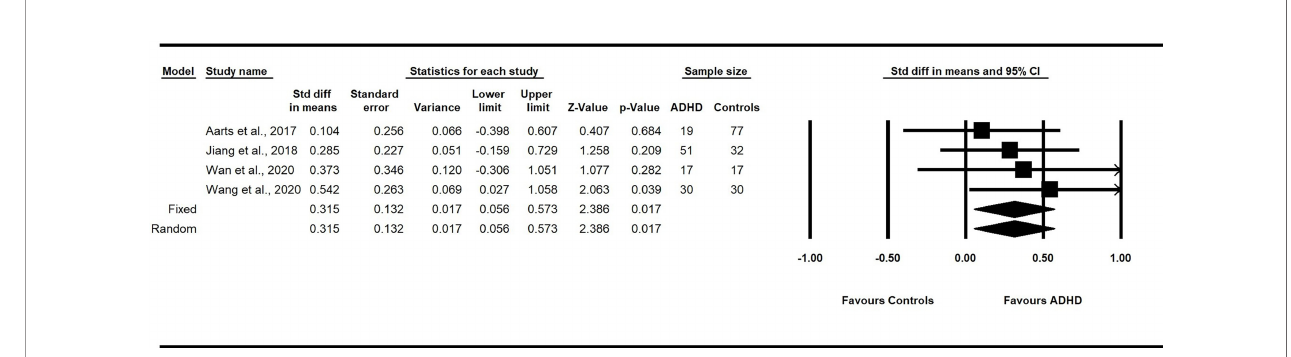
FIGURE 3 | Forest plot of the pooled effect sizes in the standardized difference in means for the Chao1 index in the fecal samples of children with and without ADHD across all studies. Children with ADHD have greater alpha diversity, as measured by the Chao1 index, compared to healthy children without ADHD ( p <.05). ADHD , Attention-De fi cit/Hyperactivity Disorder; CI , con fi dence intervals.